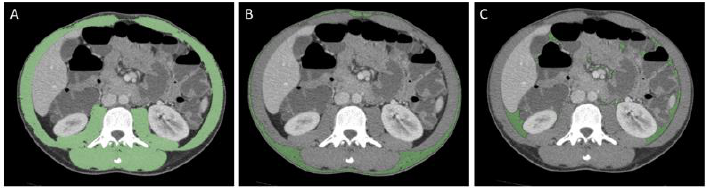
Figure 1. Representative example of assessment of muscle area ( A ), subcutaneous ( B ), and visceral fat areas ( C ) on a single slice CT-enterography at the level of L3 in a 25 yo male patient. Muscle area (MA) was calculated as the cross-sectional area of all skeletal muscles, including the psoas, paraspinal muscles, and abdominal wall muscles, selecting an attenua- tion threshold ranging from − 29 to 150 Hounsfield Unit (HU) [29]. Furthermore, skeletal mass index (SMI, MA/m2 body height) was obtained in order to correct for patients’ body height. Visceral and subcutaneous fat areas (VFA and SFA) were then calculated, setting an attenuation threshold between − 190 and − 30 HU, and VFA/SFA ratio was collected [30].